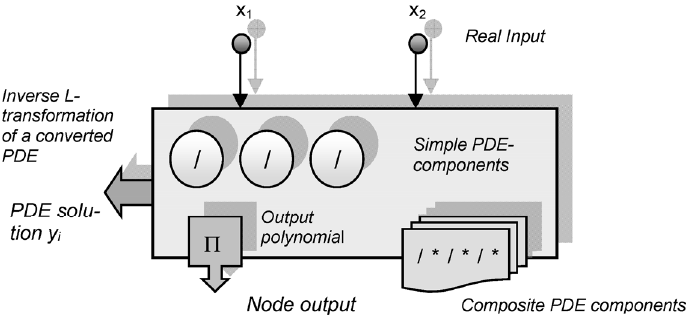
Figure 4. Blocks define and solve sub-PDEs in the chosen DNN nodes of the modular model.